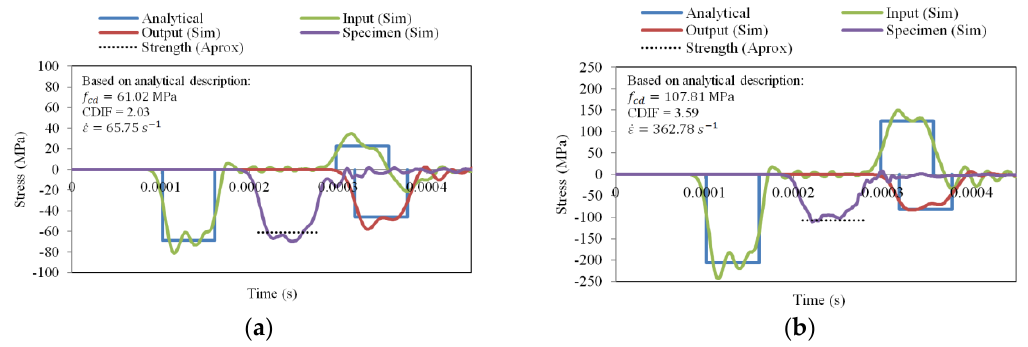
previous work [32,33]; ( a ) 10 m/s, ( b ) 30 m/s.